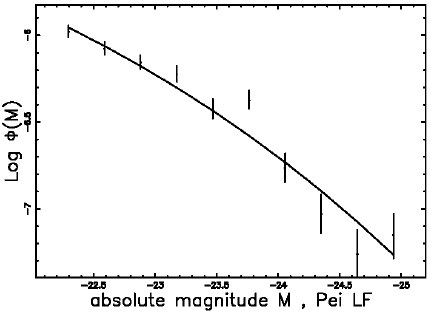
Figure 6. The observed LF for QSOs, empty stars with error bar, and the fit by the Pei LF when the redshifts cover the range [ 0.3,0.5 ]